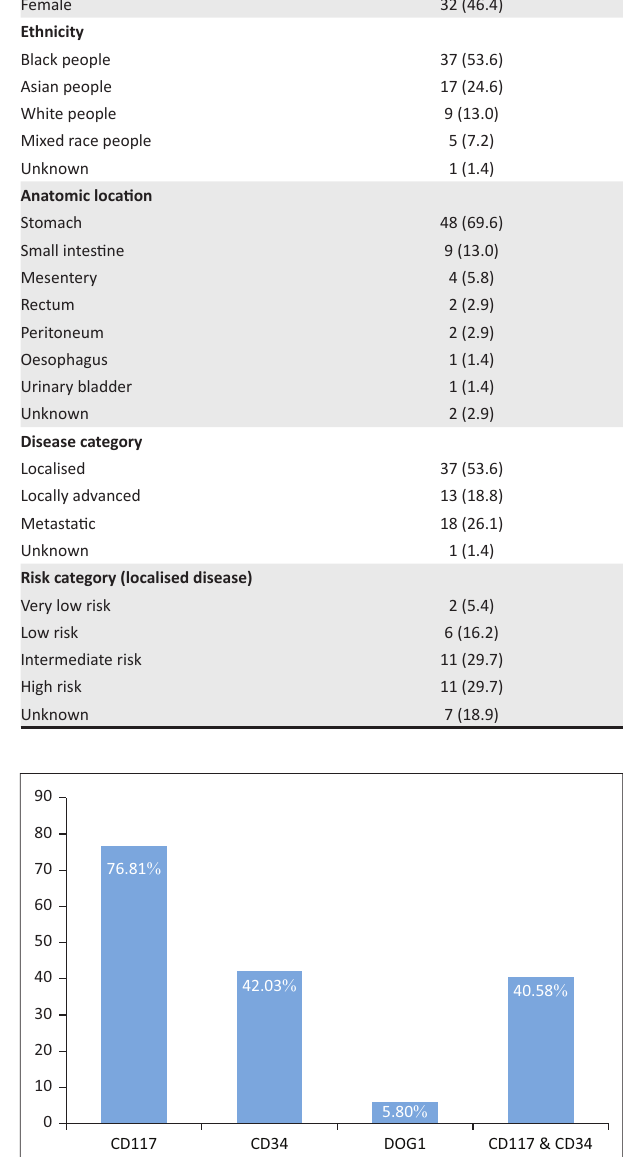
FIGURE 1: Age distribution.